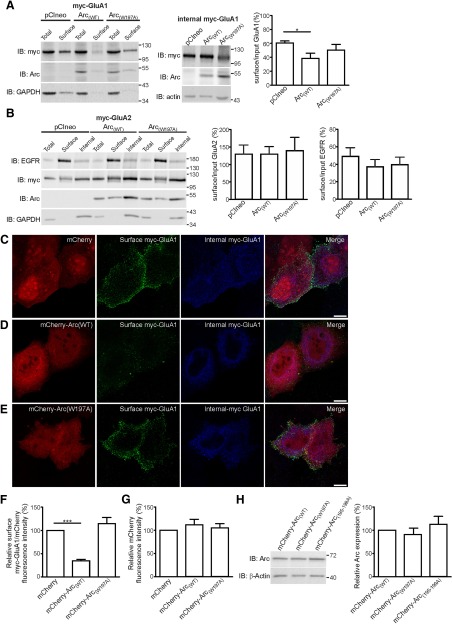
Arc–AP-2 interaction regulates GluA1 endocytosis. A, B, Representative blots showing that Arc(WT), but not the Arc(W197A) mutant, facilitates GluA1, but not GluA2 endocytosis. H4 neuroglioma cells were transfected with plasmids encoding myc-GluA1 (A) or myc-GluA2 (B) in combination with either: empty pCIneo vector, pCIneo Arc(WT), or pCIneo Arc(W197A). Western blot band densitometry analysis showing that: (A) Arc(WT), but not Arc(W197A), promotes a significant reduction in surface expression of GluA1 subunits (control: 60.46 ± 2.97%; Arc(WT): 38.55 ± 7.44%; Arc(W197A): 50.18 ± 8.34%. Error bars represent mean ± SEM (n = 3 independent experiments). *p<0.05 using one-way ANOVA followed by Tukeýs post-test. B, Arc(WT) does not promote any changes in surface expression of either GluA2 subunits (control: 132.9 ± 26.66%; Arc(WT): 133.2 ± 21,78%; Arc(W197A): 143.9 ± 38.43%) or EGF receptor (control: 51.35 ± 10.43%; Arc(WT): 38.93 ± 8.66%; Arc(W197A): 41.59 ± 8.8%). Error bars represent mean ± SEM (n = 4 independent experiments).Ten percent of the protein lysate used for incubate the beads was loaded in the input lane. GAPDH was used as loading controls. C–F, C–G, H4 cells coexpressing myc-GluA1 with either mCherry construct alone (C), mCherry-Arc(WT) (D), or mCherry-Arc(W197A) (E). Surface myc-GluA1 (non-permeabilized cells, green channel) was identified using mouse anti-myc antibody followed by AlexaFluor 488 secondary antibody and internal myc-GluA1 (permeabilized, magenta channel) was identified by polyclonal rabbit anti-myc antibody followed by AlexaFluor 647 secondary antibody. F, G, The mean florescence intensity (MFI) of AlexaFluor 488 (surface my-GluA1) and mCherry (red channel) were calculated using confocal Z-projection images to quantify the pixel intensity of surface myc-GluA1 and mCherry (total protein expression). F, Ratio of averaged MFI between surface (488)/total protein (mCherry) for control cells (n=59 cells) was set to 100% to facilitate comparison. Note that the ratio for surface GluA1 is significantly reduced in cells expressing mCherry-Arc(WT) (34.68 ± 3.13%; n= 60 cells) compared with cells expressing mCherry construct alone. Importantly, this reduction is absent in cells expressing the mCherry-Arc(W197A) construct (114.80 ± 13.08%; n= 42 cells. G, Bar chart plotting the averaged MFI expression levels of mCherry-Arc(WT) and mCherry-Arc(W197A) compared with mCherry expression. Values are mean ± SEM (n=3 independent experiments). *p<0.05, ***p<0.005 using one-way ANOVA followed by Tukeýs post-test. Scale bar, 10 μm. H, Representative blot and bar chart plotting bands densitometry analysis of Arc expression protein in H4 cells transfected with equal amounts of mCherry-Arc(WT), mCherry-Arc(W197A), or mCherry-Arc(195-199A) plasmids. Note the similar levels Arc protein expression between samples. Values are mean ± SEM (n=3 independent experiments).